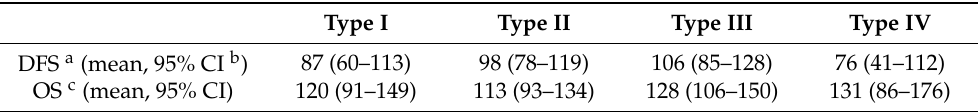
Figure 3. Kaplan–Meier curves for overall survival according to Borrmann type. The p -value by log- rank test was 0.895. Table 6. Mean disease-free and overall survival times according to Borrmann type. Type I